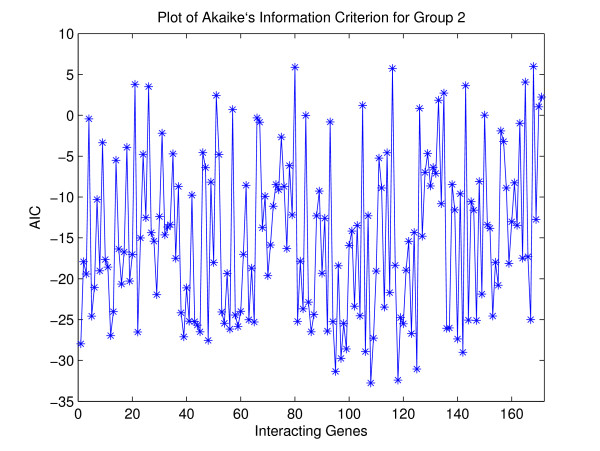
AIC plots for [see Additional file 1].